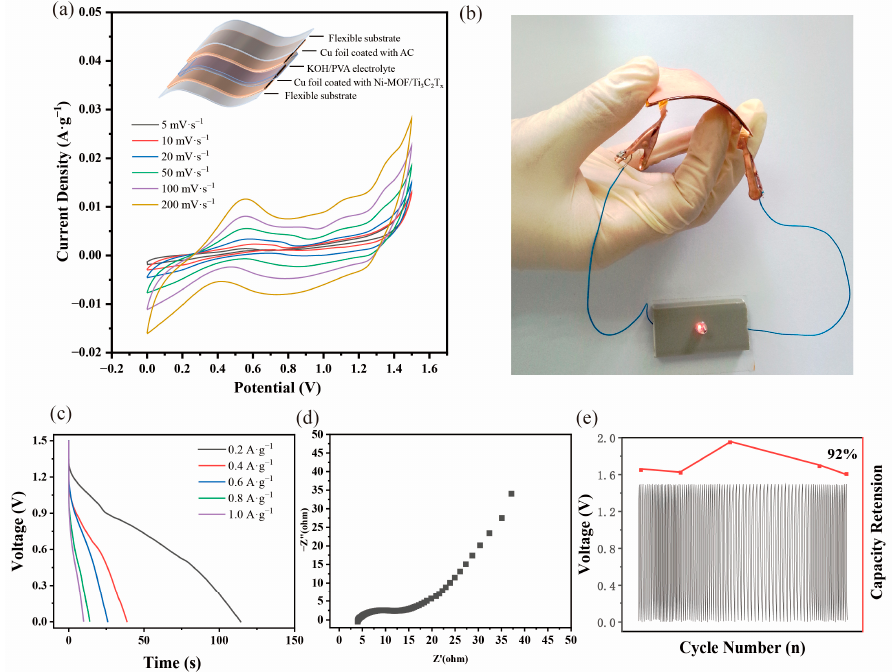
Figure 5. ( a ) Schematic illustration of flexible supercapacitor and the CV electrochemical test of the device; ( b ) success in lighting a LED; ( c ) the GCD curves of the device; ( d ) the EIS curves of the device; and ( e ) the cycle test of the device.